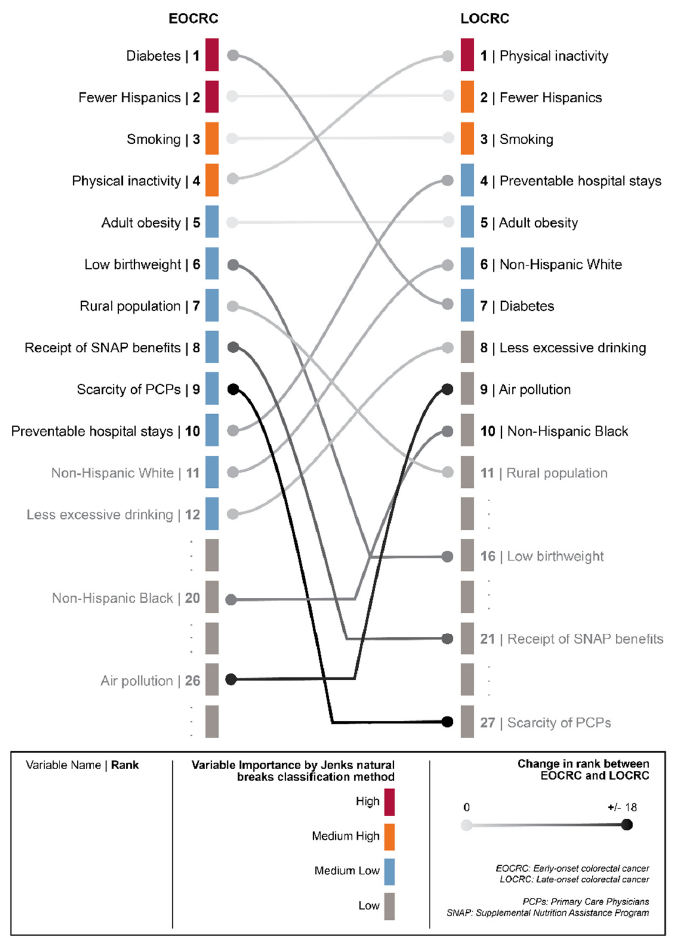
Figure 3. Comparisons of the top ten risk factors based on variable importance between EOCRC and LOCRC models.